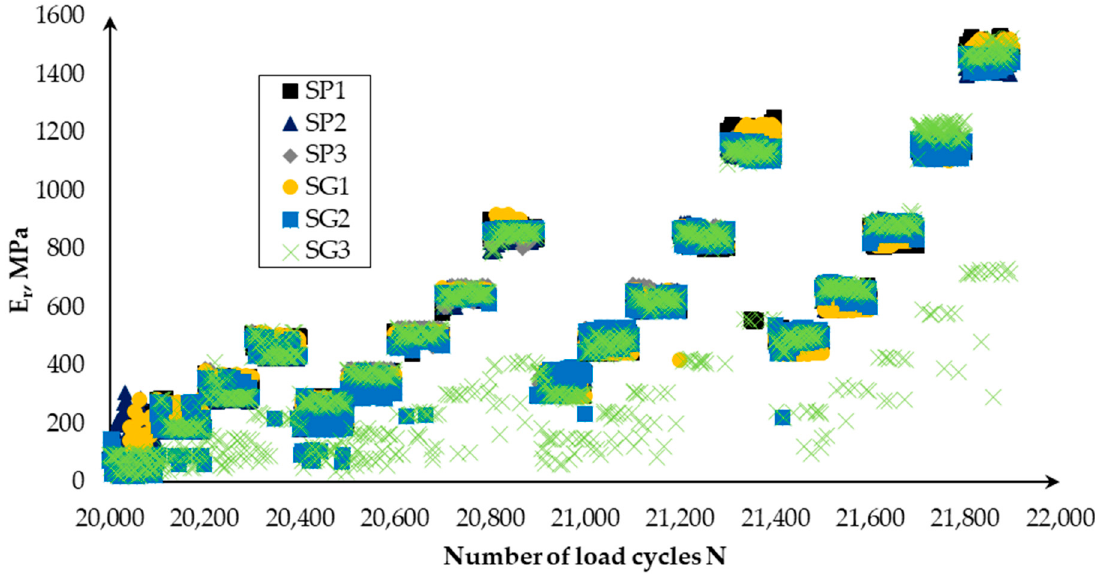
Figure 5. Obtained values of resilient modulus at a certain number of cycles.